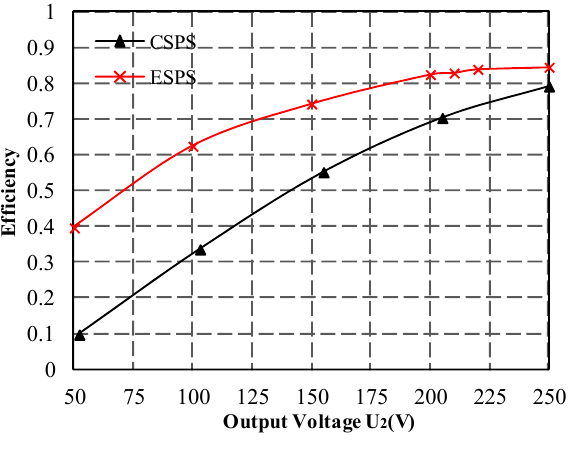
Figure 12. Comparison of system efficiency between CSPS and ESPS